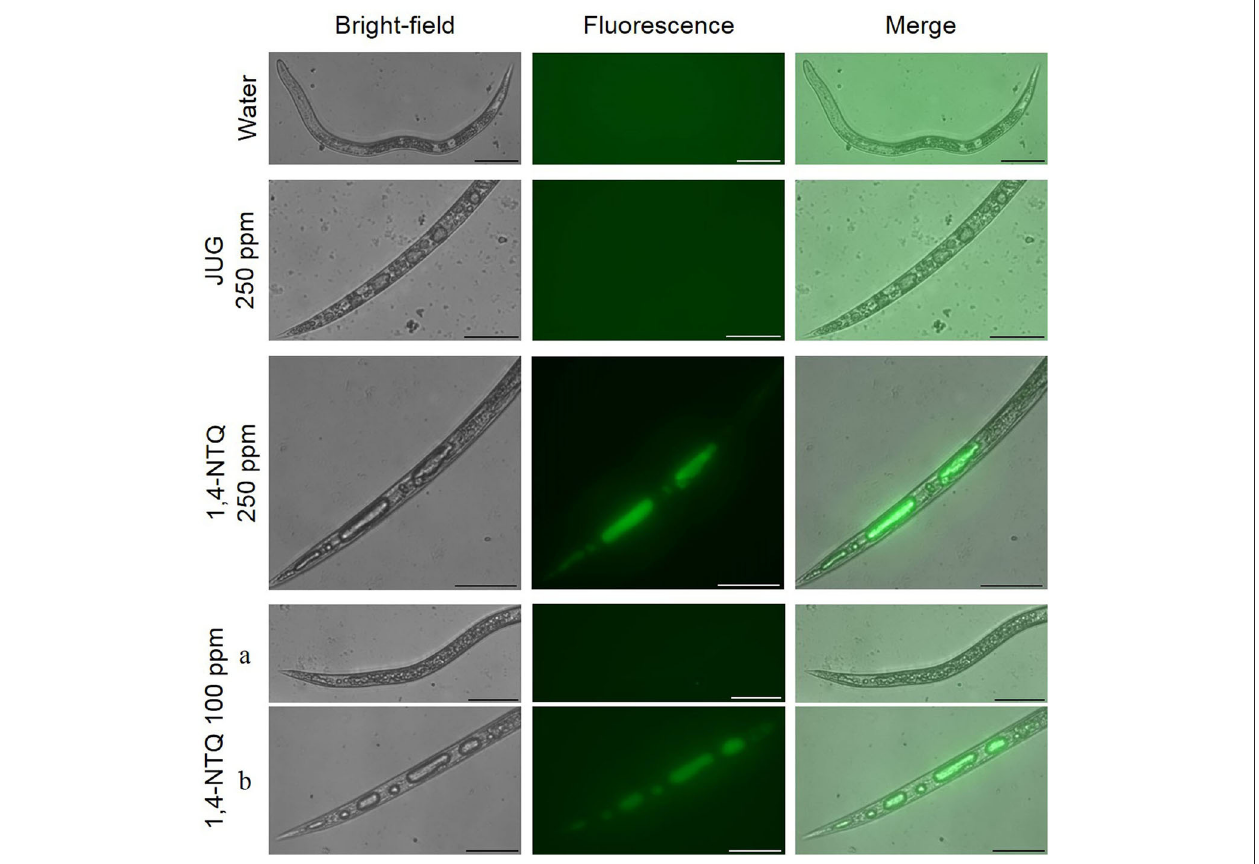
FIGURE 6 | Effects of juglone (JUG) and 1,4-naphthoquinone (1,4-NTQ) on reactive oxygen species production in Meloidogyne luci second-stage juveniles’ mortality. Nematodes were exposed to JUG and 1,4-NTQ at 100 and 250 ppm for 3 days. At 1,4-NTQ 100 ppm, some nematodes remained mobile (a) and others were dead (b) . Scale bars = 50 µ